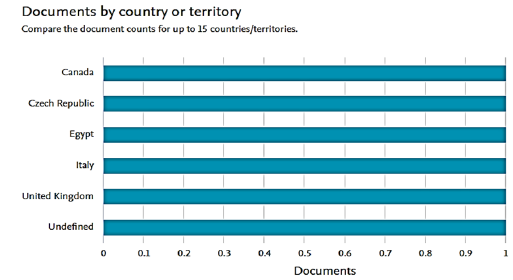
Fig. 8. Countries that published related to the words “hemp”, “thermal”, “insulating” and “brick”. Source: Sco- pus scientific